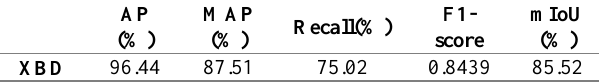
Table 2. Test results of the model on xBD